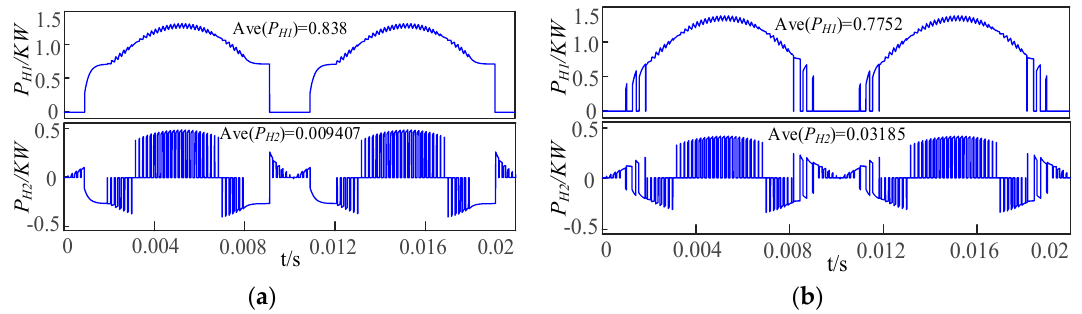
Figure 9. Instantaneous power output of units at all levels. ( a ) HF-PWM modulation. ( b ) MHF-PWM modulation.